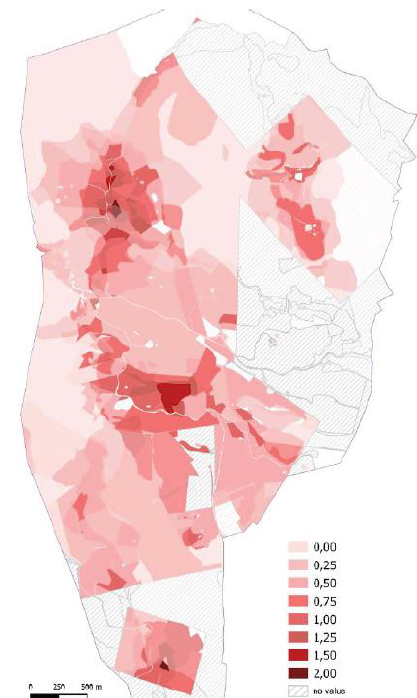
Figure 13 . Great War Impact Factor: general overview mapping